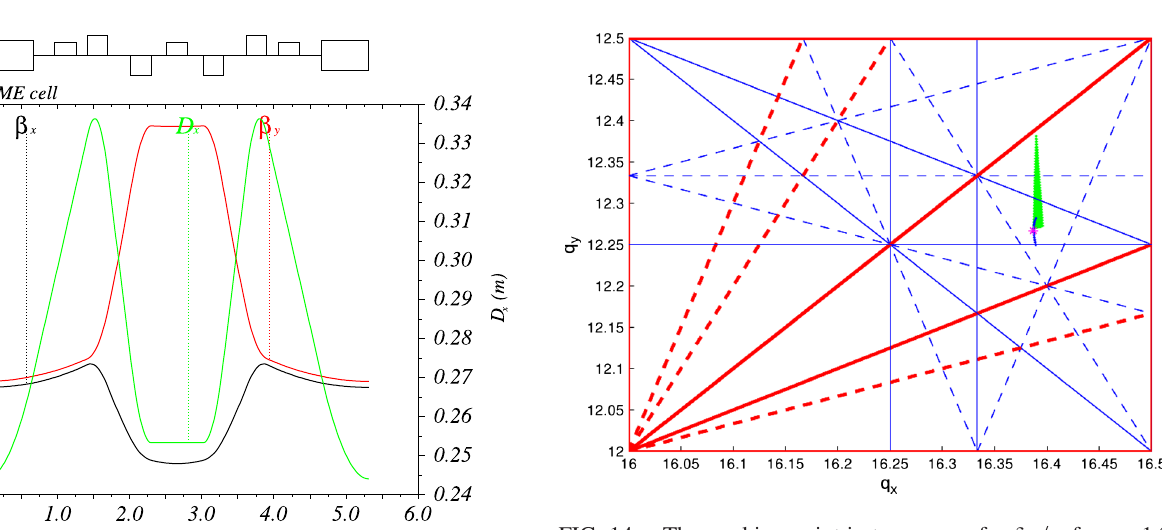
FIG. 14. The working point in tune space for δ p=p from − 1 . 2 to 1.2% (blue) and the first order tune shift with amplitude up to 6 σ (green). The on-momentum working point is